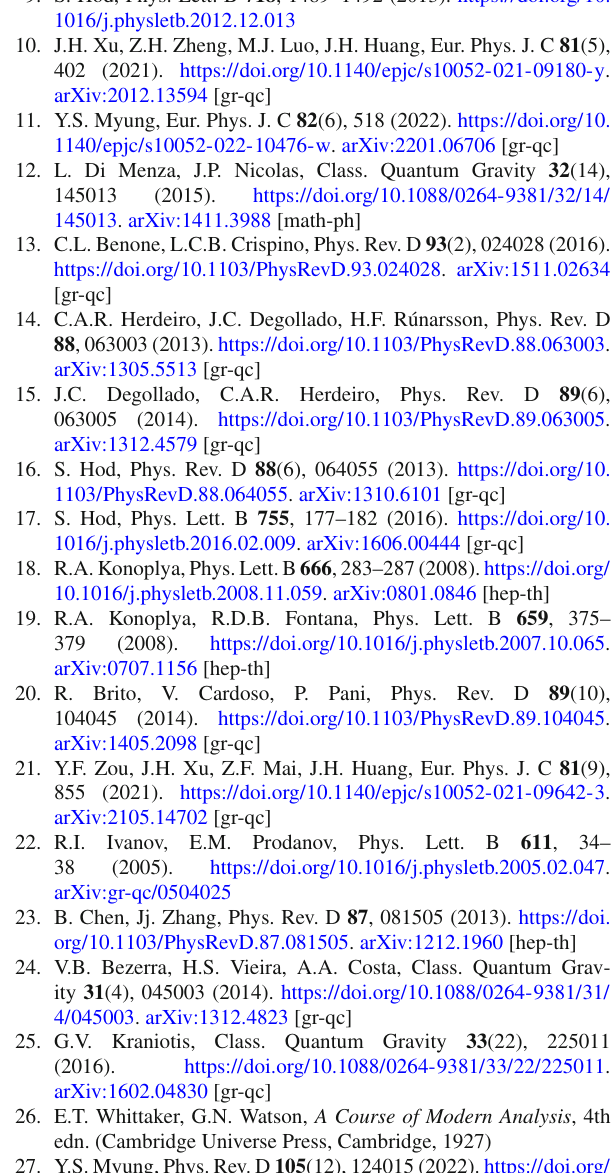
such a complete analysis for superradiant instability around the RN black holes in the